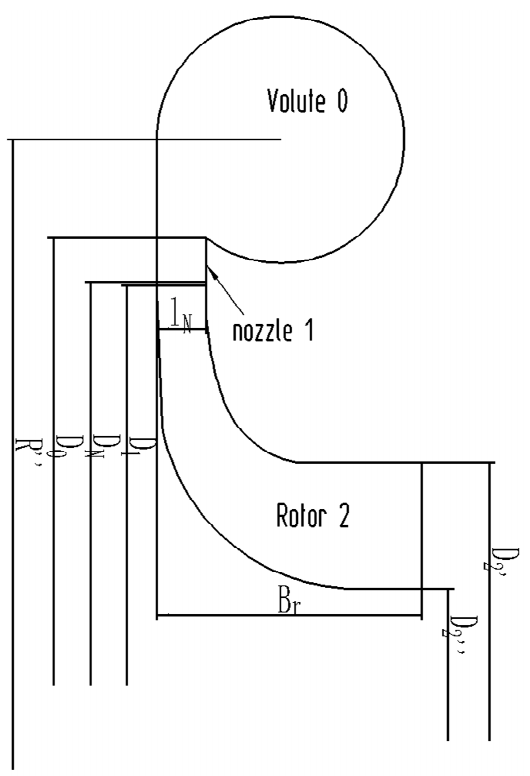
J. Mar. Sci. Eng. 2021 , 9 , x FOR PEER REVIEW Figure 2. Schematic of the radial inflow turbine meridional view. Figure 2. Schematic of the radial inflow turbine meridional view.